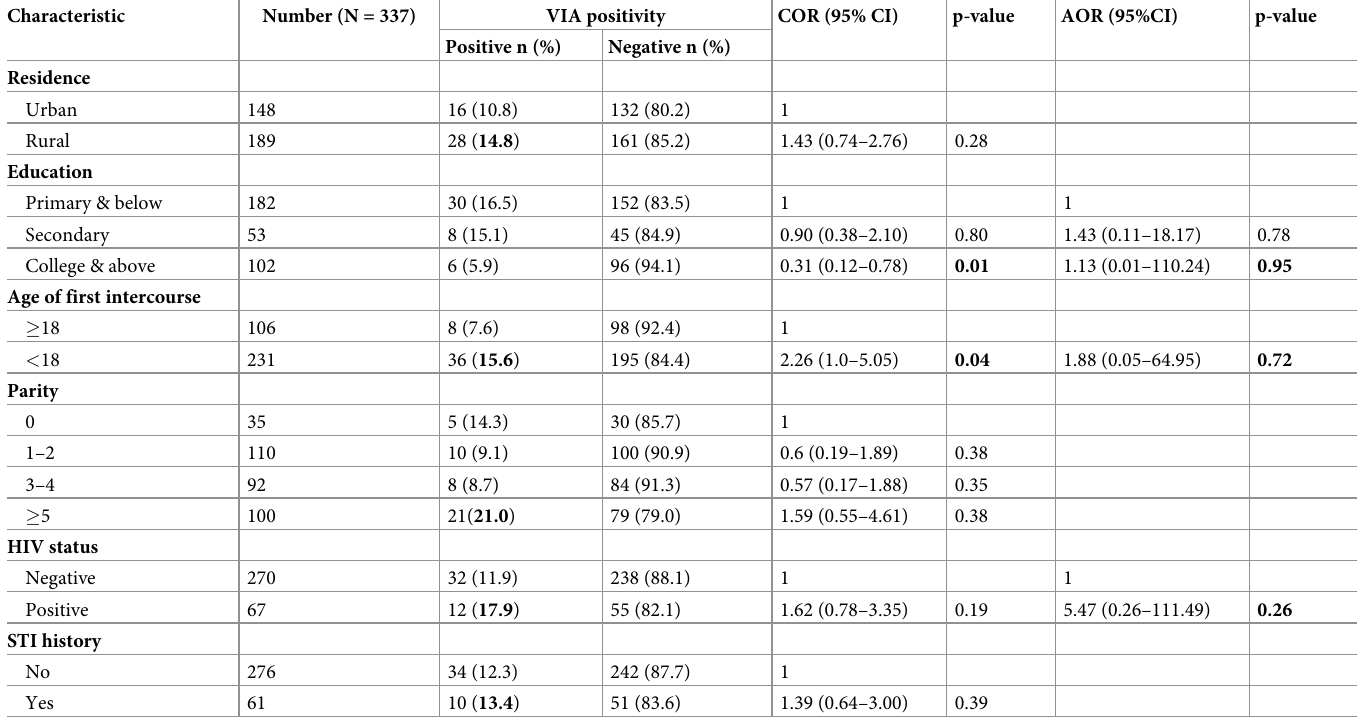
Table 6. Logistic regression analysis of VIA positivity among participant women (n = 337) aged 21–49 years, Amhara region, Ethiopia, 2019.